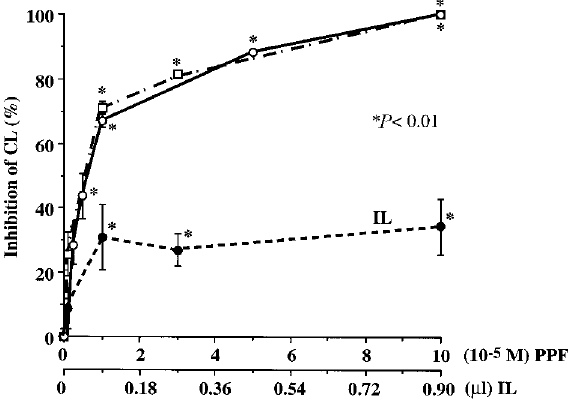
FIG. 2. Inhibition (±SD) of the CL of endothelial cells by pure PPF dissolved in carbitol ( s